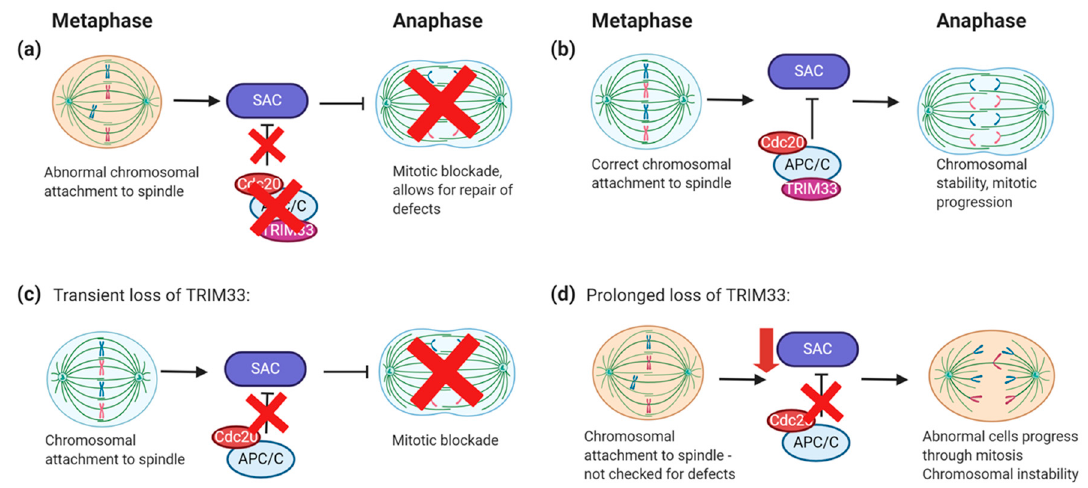
Figure 5. Regulation of the spindle assembly checkpoint (SAC) by TRIM33. During metaphase, chromosomes attach to microtubules and align along the equator. Sister chromatids must be